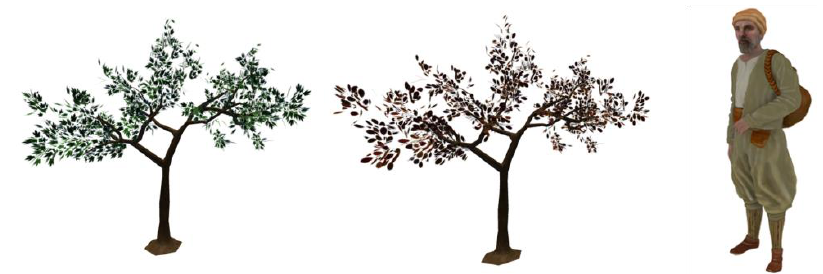
Figure 5. Reconstruction of the Ottoman bath.